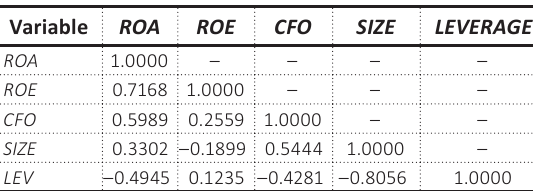
Table 3. Correlation analysis of study variables